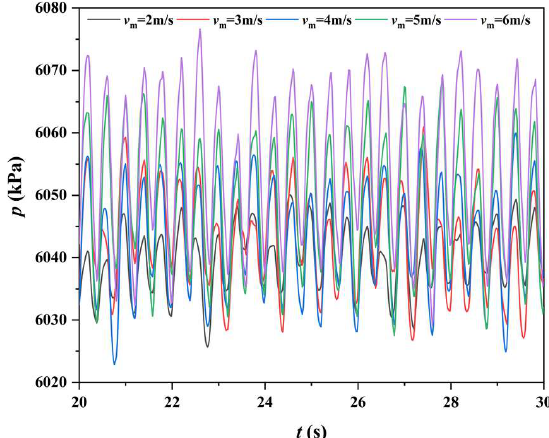
Figure 18. Comparison of the pressure ( p ) acting on Bend 3 at different mixture velocities, where v m is the mixture velocity.